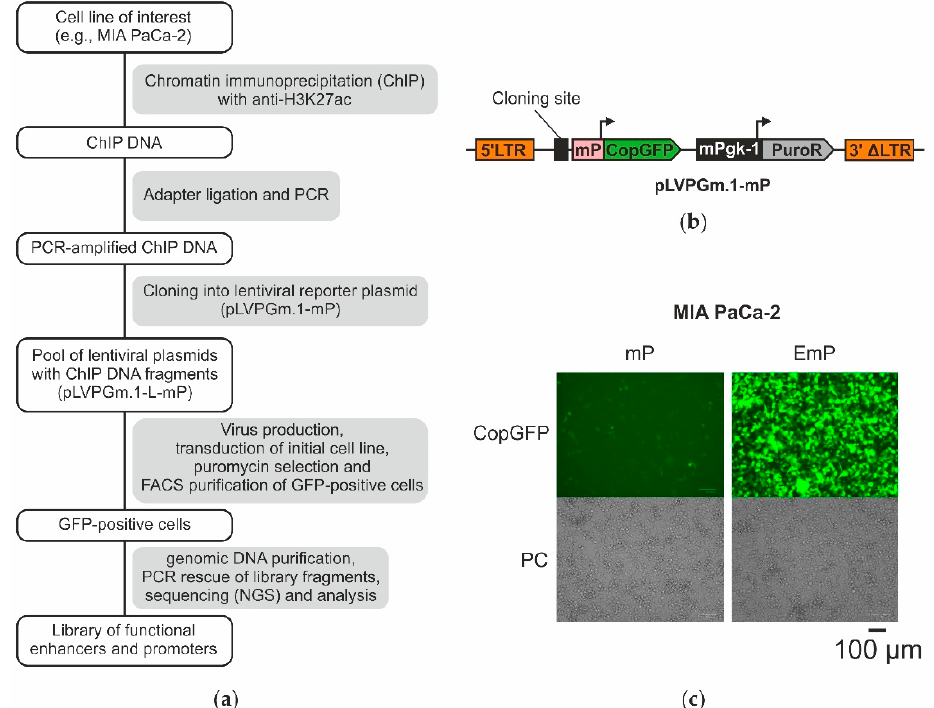
Figure 1. Selection of functional enhancers and promoters active in MIA PaCa-2 cells using lentiviral reporter system. ( a ) Flow chart of experimental design. We combined the method of chromatin immunoprecipitation (ChIP) and massive parallel functional assay using lentiviral reporter system (MPRA). ChIP of MIA PaCa-2 cells using H3K27ac antibody was performed for primary enrichment of the library with active enhancers and promoters. FACS was used for isolation of MIA PaCa-2 cells transduced by the lentiviral library and containing vectors with active elements. ( b ) Lentivirus vector pLVPGm.1-mP developed for the search of regulatory elements. Promoters and enhancers inserted in the cloning site should enhance activity of minimal CMV promoter in transduced cells expressing reporter gene of green fluorescent protein (CopGFP). mPgk-1-PuroR—puromycin resistance gene under control of murine Pgk-1 gene universal promoter. 5’LTR/3’ Δ LTR—long terminal repeats. ( c ) Test of functionality of pLVPGm.1-mP vector. MIA PaCa-2 cells were transduced by basic vector without enhancer (mP) or by control vector containing CMV enhancer (EmP). CopGFP—fluorescence microphotography; PC—phase contrast microscopy.